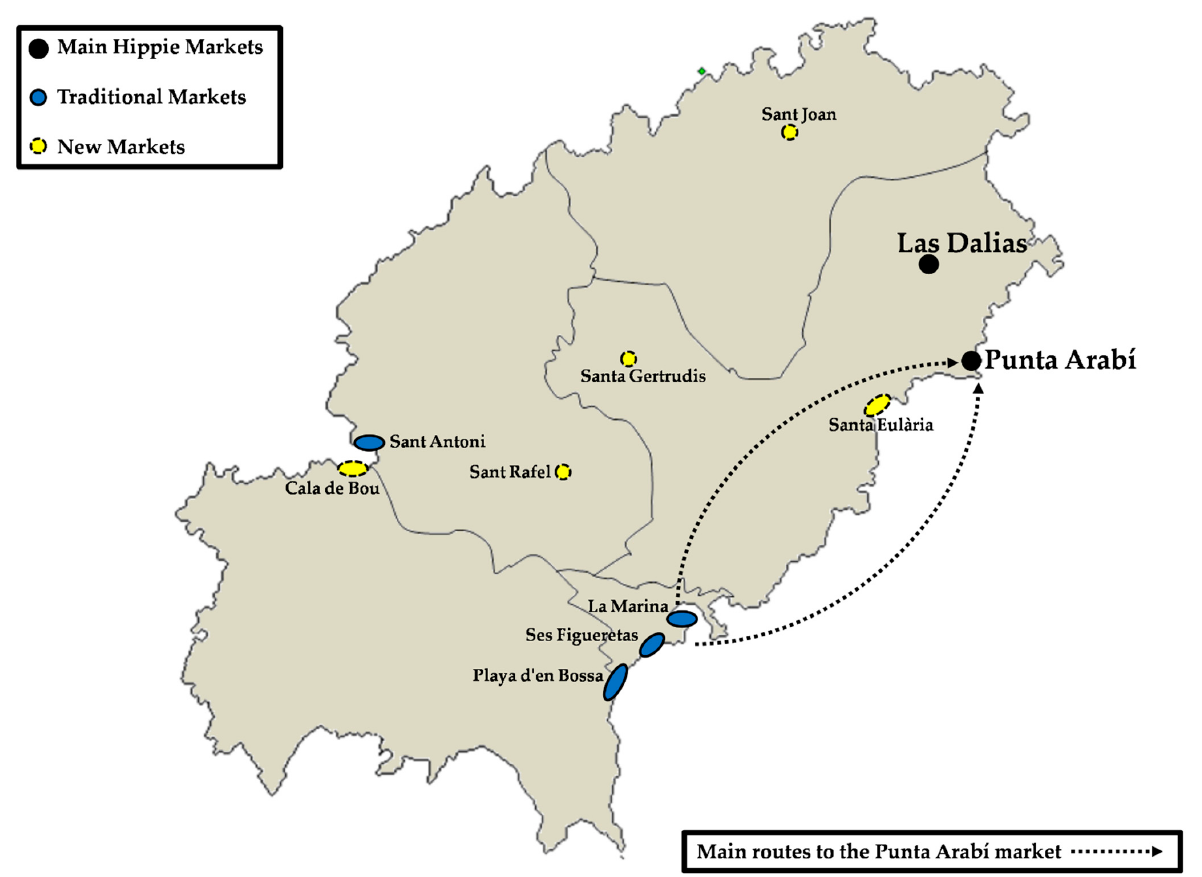
Figure 4. Hippie markets and handicraft markets in 2021 (authors’ own